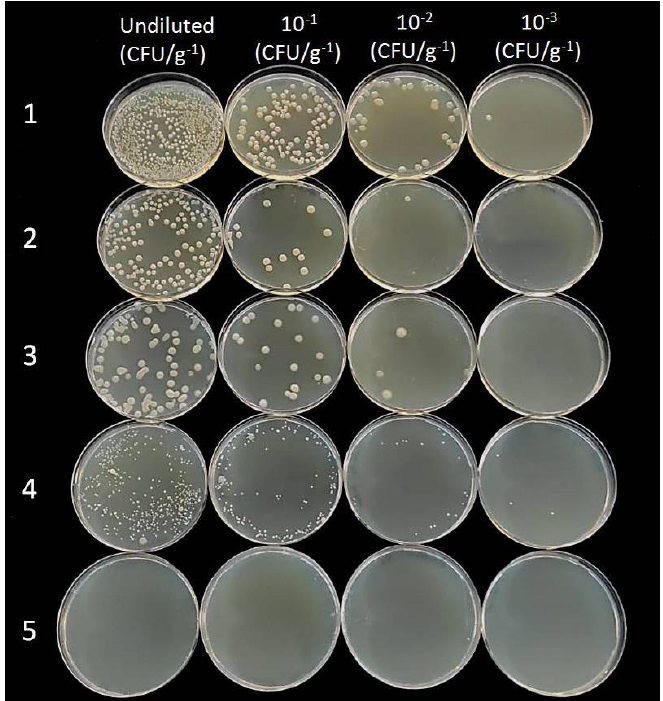
Figure 6. Recovery of bacterial strains from Citrus volkameriana woody stems on PDA plates after 48 h compared with control plates: 1, B. amyloliquefaciens MBI600 (Serifel ® ); 2, B. amyloliquefaciens D747 (Amylo-X ® ); 3, B . amyloliquefaciens QST713 (former B. subtilis ; Serenade ® Aso); 4, B . amyloliquefaciens strain FZB24 (Taegro ® ); 5, control plates.